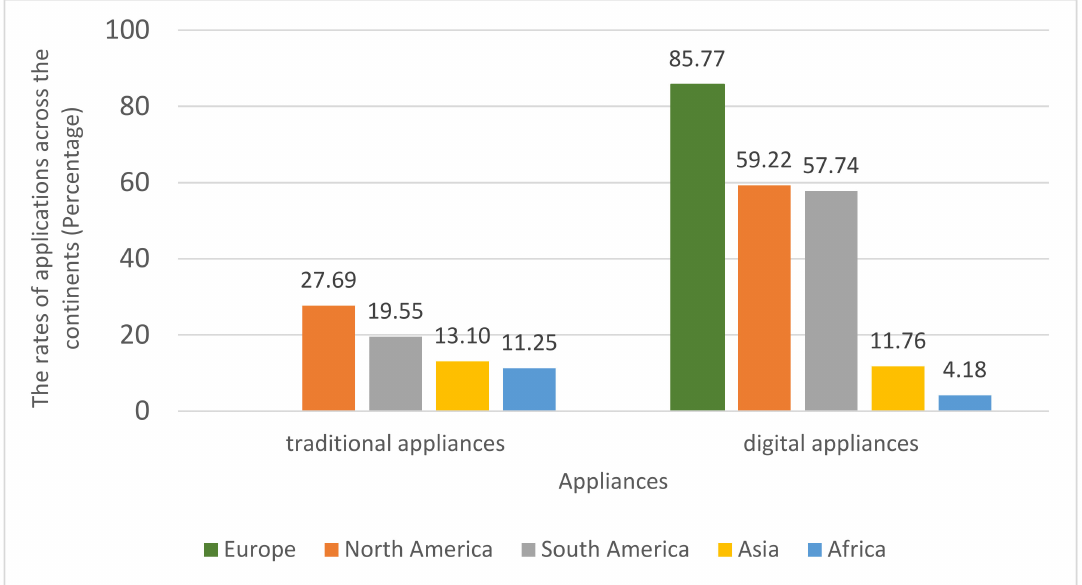
Figure 2. The rates of traditional applications and modern applications across the continents.